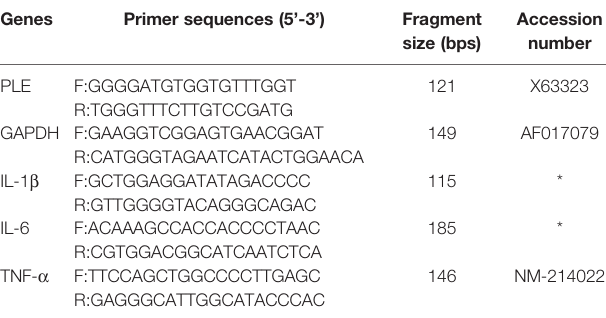
TABLE 2 | The primer sequences for